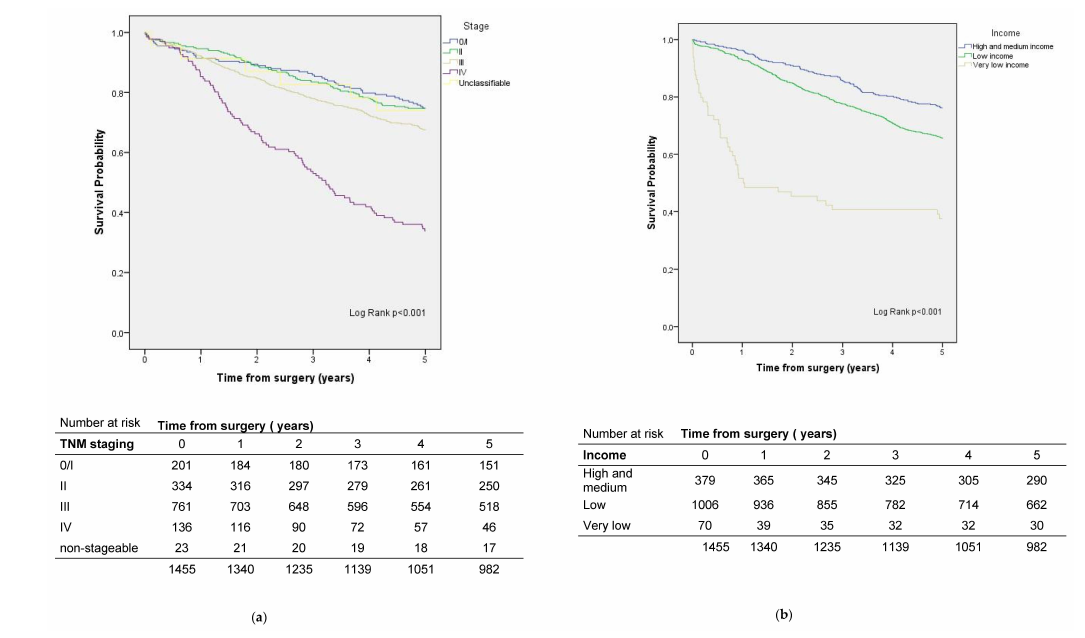
Figure 5. Survival by ( a ) stage and ( b ) socioeconomic status in rectal cancer patients. Table 4. Multivariate survival analysis of rectal cancer patients at 5 years of follow-up. Univariate Analysis Multivariate